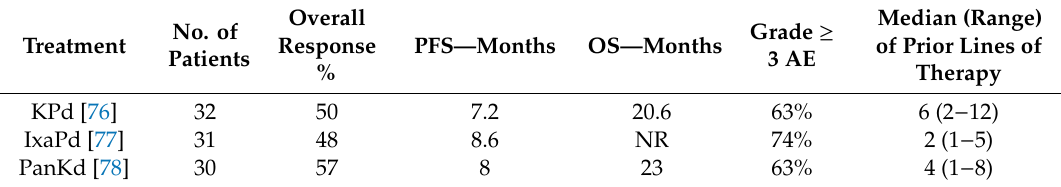
Table 6. Phase I studies of alternative regimens for late relapses in